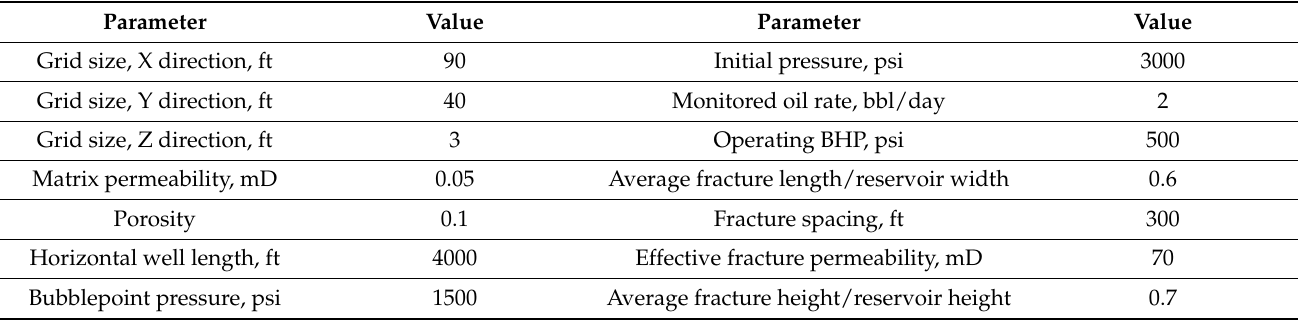
Table 4. Parameters of the base case.